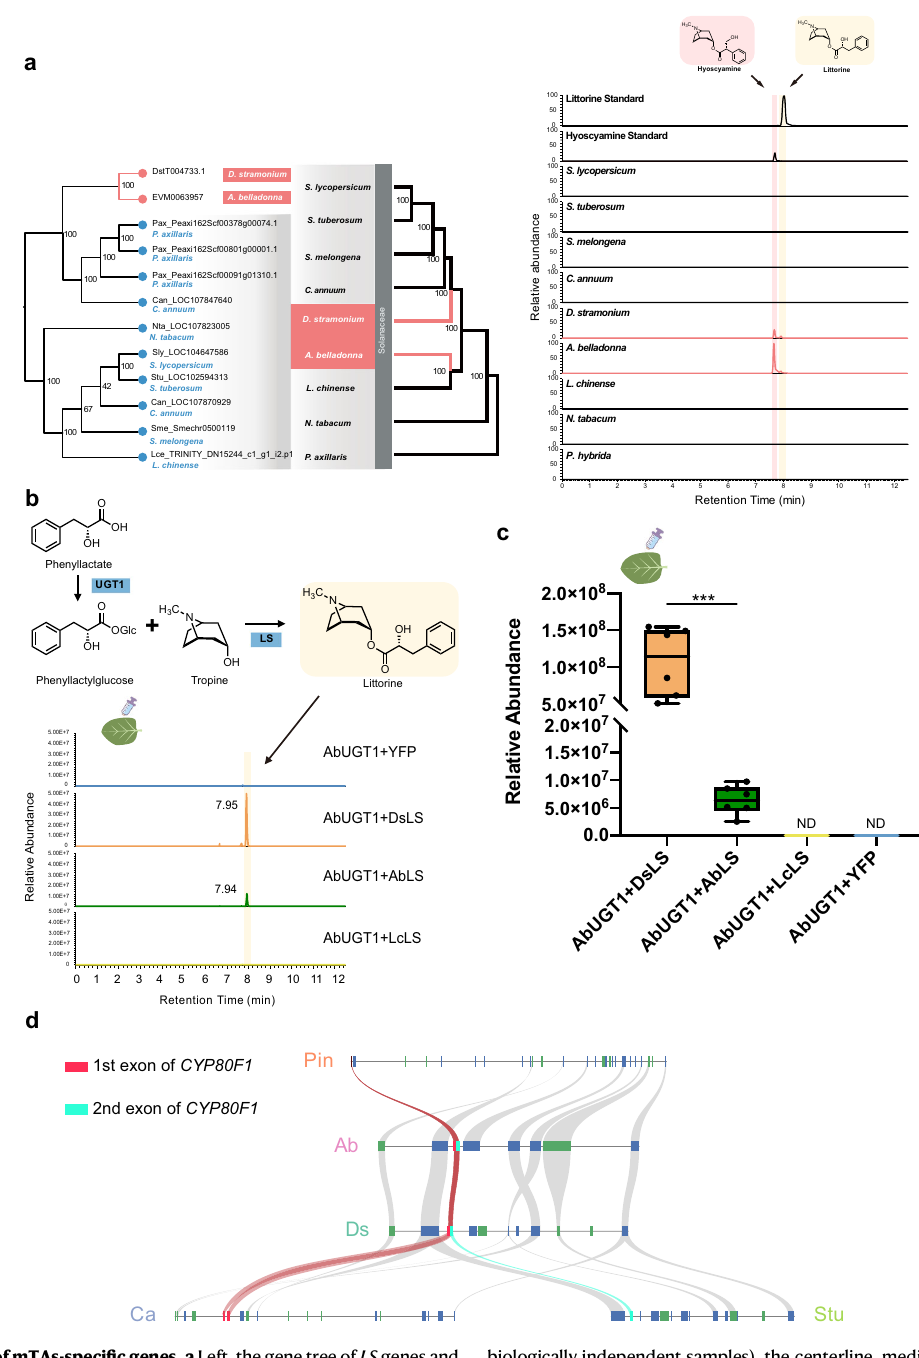
biologically independent samples), the centerline, median; box limits, upper and lower quartiles; whiskers, data range. *** represented signi fi cant difference ana- lyzed by two-sided Student ’ s t -test at the level of P <0.001. *** P =0.0004 (AbUGT1+DsLS compared with AbUGT1+AbLS). ND not detectable. d Synteny analysisofthe CYP80F1 geneindifferenttribes.Pin, P . in fl ata ;Ab, A . belladonna ;Ds, D. stramonium ; Ca, C. annuum ; Stu, S. tuberosum . Syntenic pieces of CYP80F1 are highlighted in red.The red rectangleonthe chromosome represents the fi rstexon of CYP80F1 ; the light blue rectangle on the chromosome represents the second exon of CYP80F1 . Source data underlying c is provided as a Source Data fi